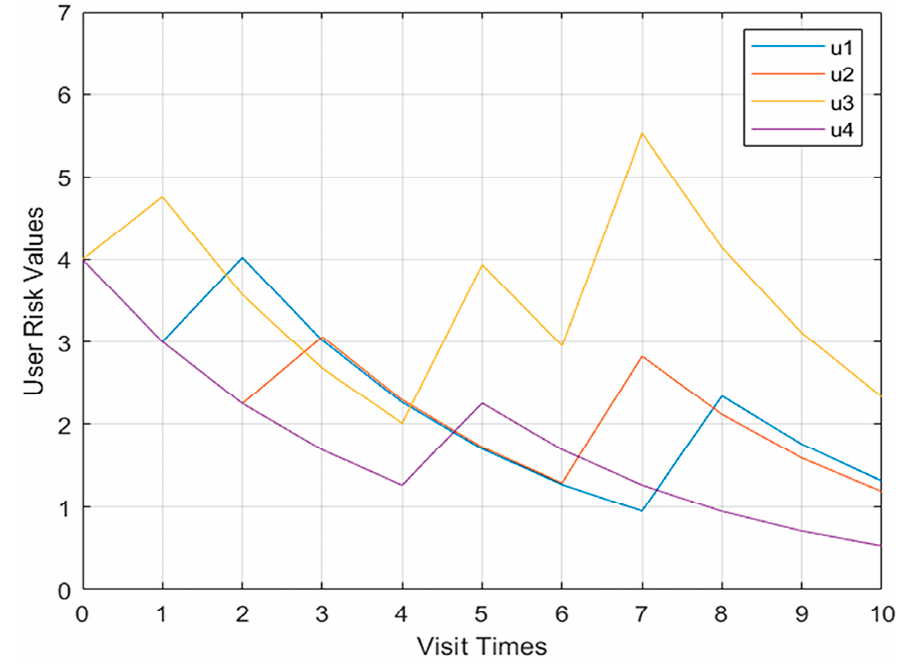
Figure 8. Change curve of multi-user behavior risk value in Model 2.